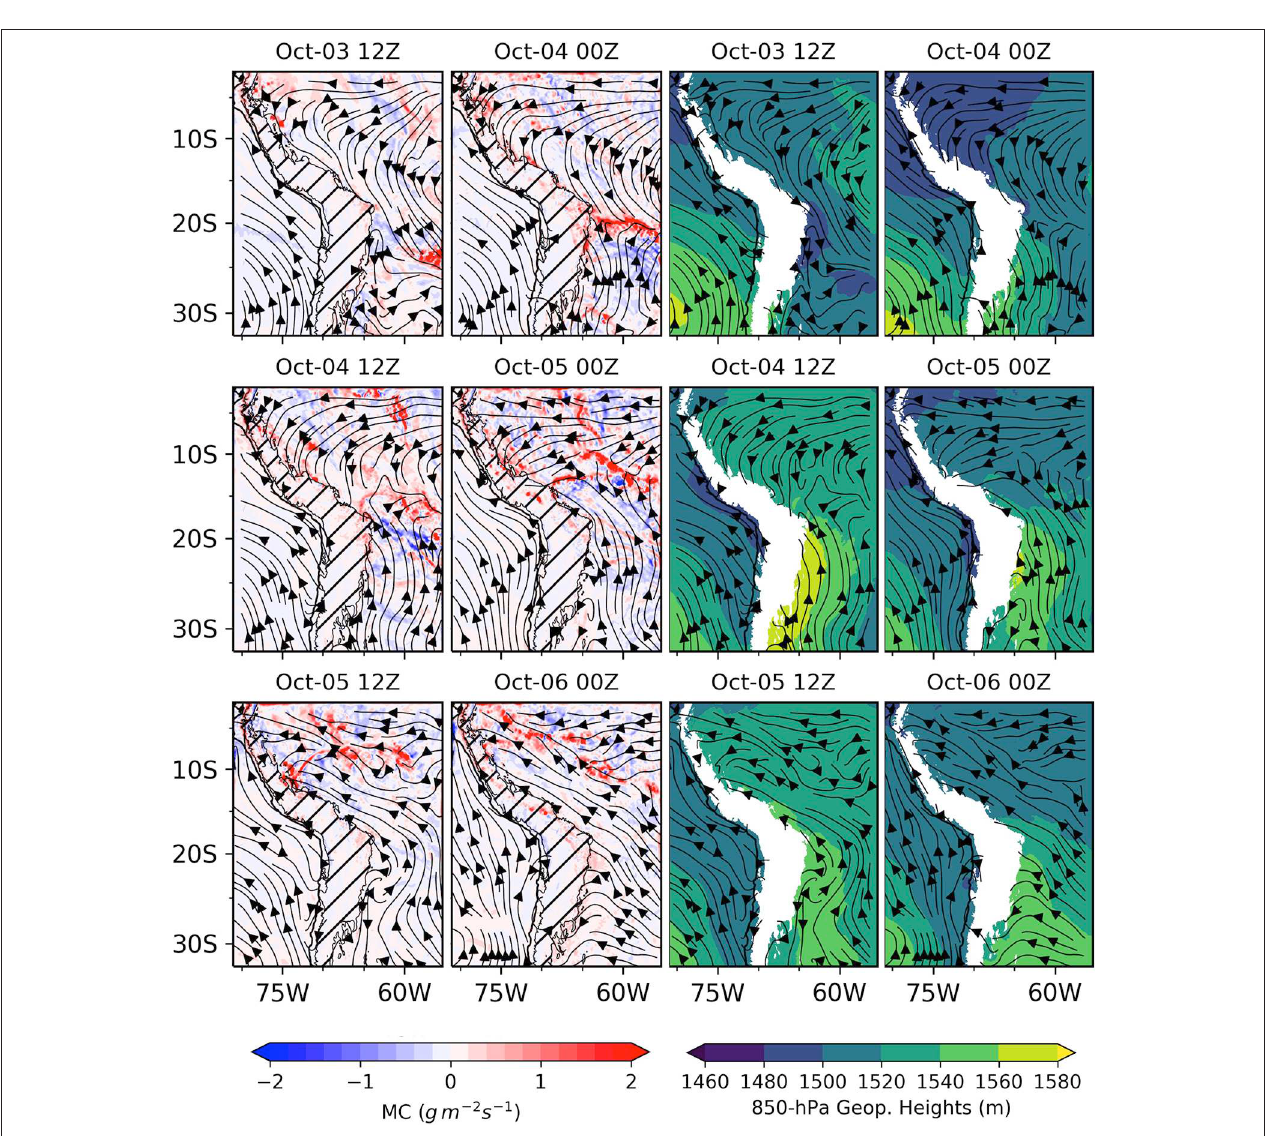
FIGURE 6 | WRF simulation ( D 02, 6 km ) of the CAI event on October 3–7, 2013. The first two columns show the integrated moisture convergence (MC) and 850 hPa level horizontal wind streamlines. The 1500 m orography is shown by southwest-northeast hatching. The second two columns show the 850 hPa level geopotential heights and horizontal wind streamlines. The white region is the area with pressures lower than 850 hPa